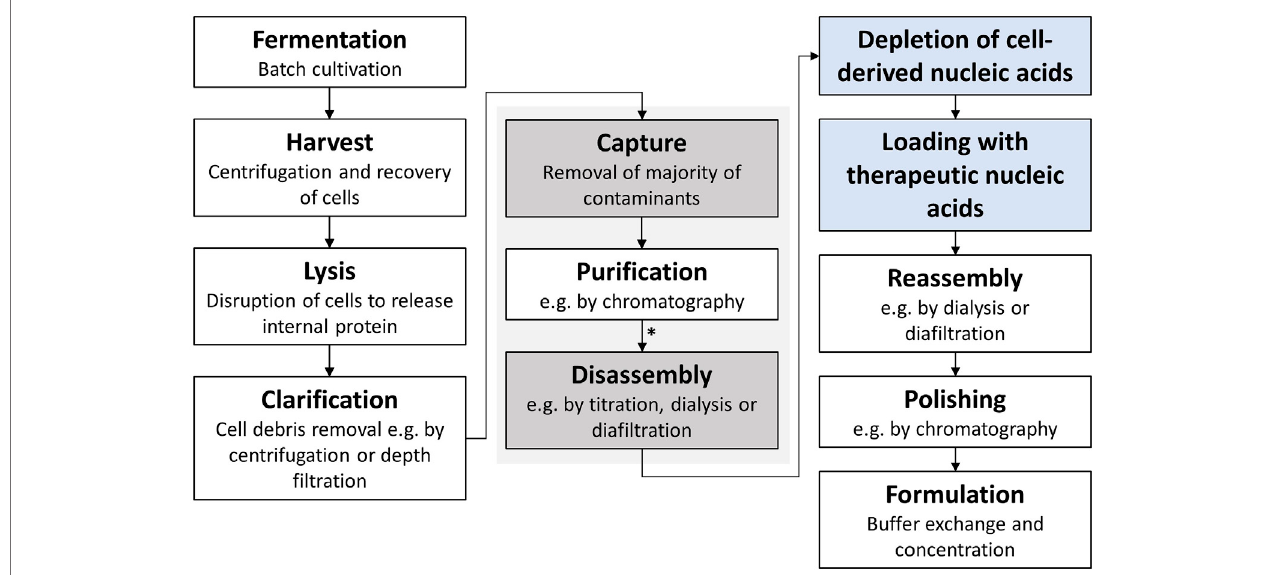
FIGURE 1 | Typical HBcAg VLP puri fi cation process (Hillebrandt et al., 2021) with additional process steps for application as a transport vector for nucleic acids highlighted in blue. The central puri fi cation steps captured by selective precipitation and disassembly, investigated in this study, are highlighted in grey. HBcAg VLP constructcharacterizationwasconductedafterpuri fi cationbyCaptoCore400chromatographyanddialysis(markedwithanasterisk*).HBcAg,hepatitisBcoreantigen; VLP, virus-like particle.